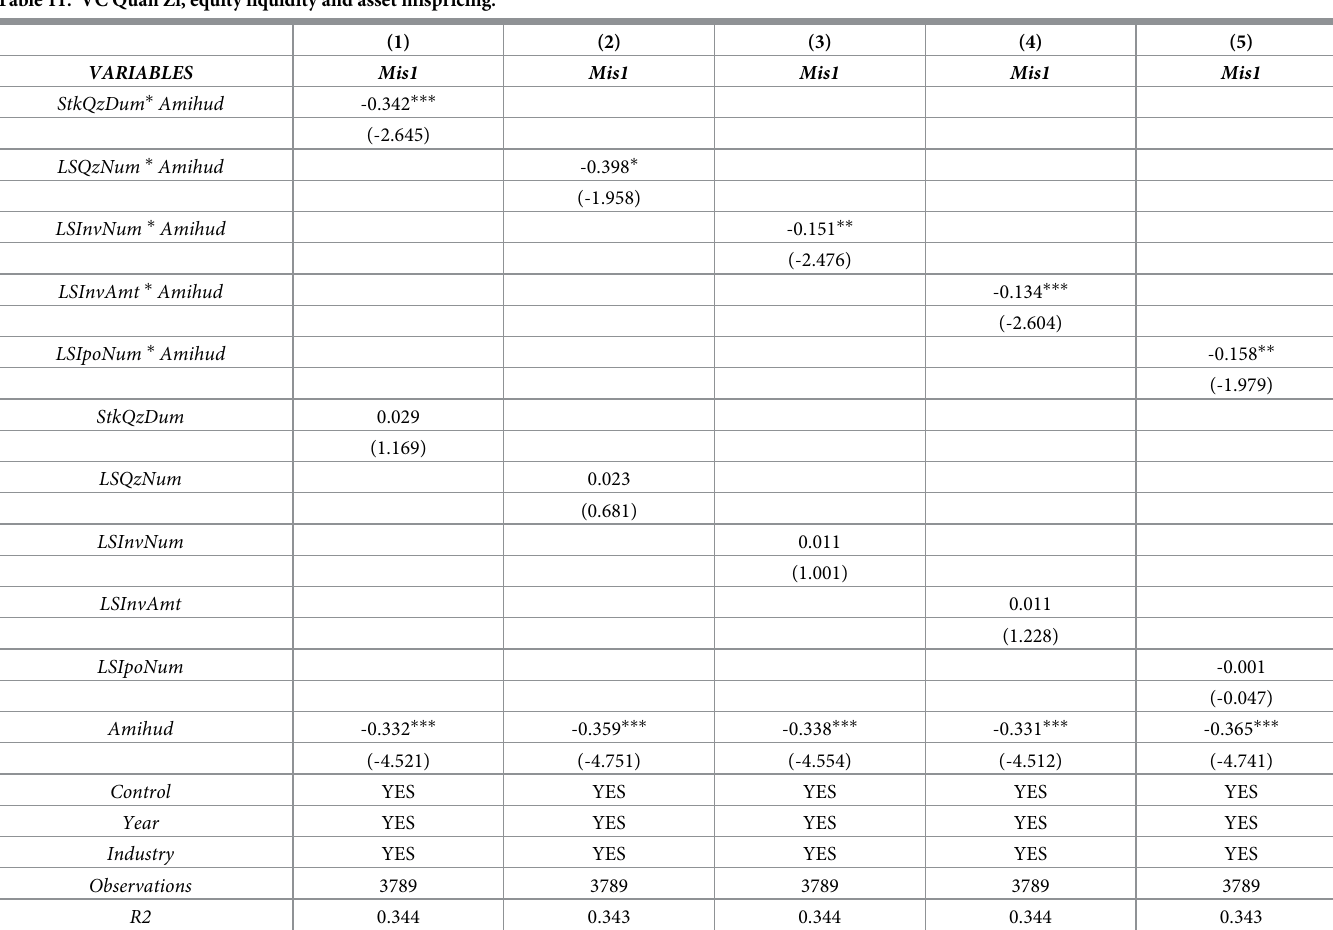
Table 11. VC Quan Zi, equity liquidity and asset